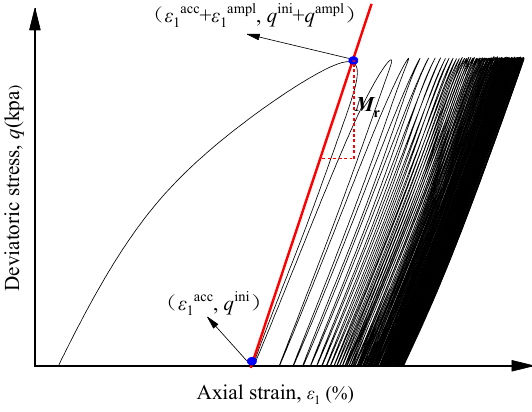
Figure 4. Typical hysteresis loop of the sample.